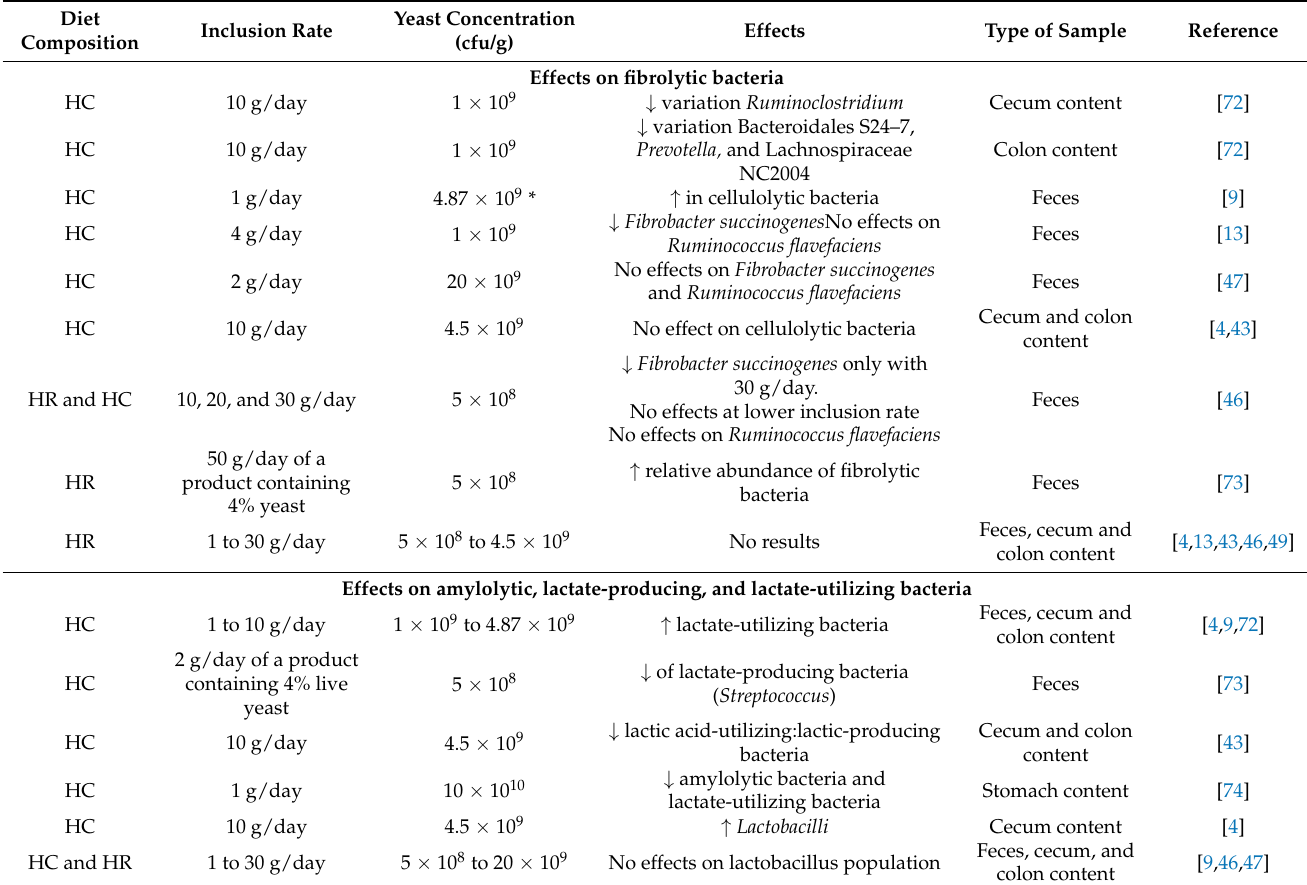
Table 2. Effects of S. cerevisiae on intestinal and fecal microbial population of